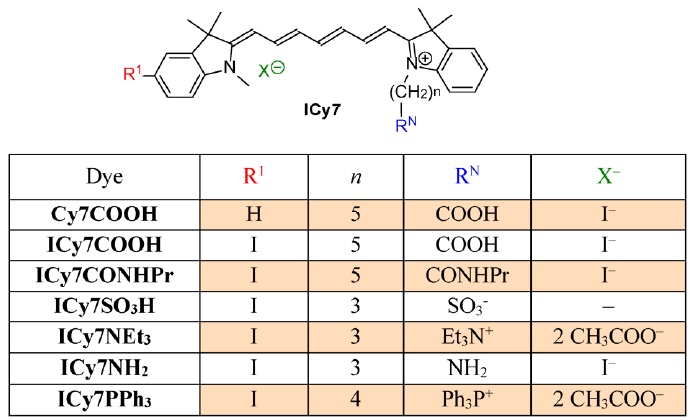
Figure 2. Heptamethine cyanine dyes of ICy7 series obtained and studied in this work.